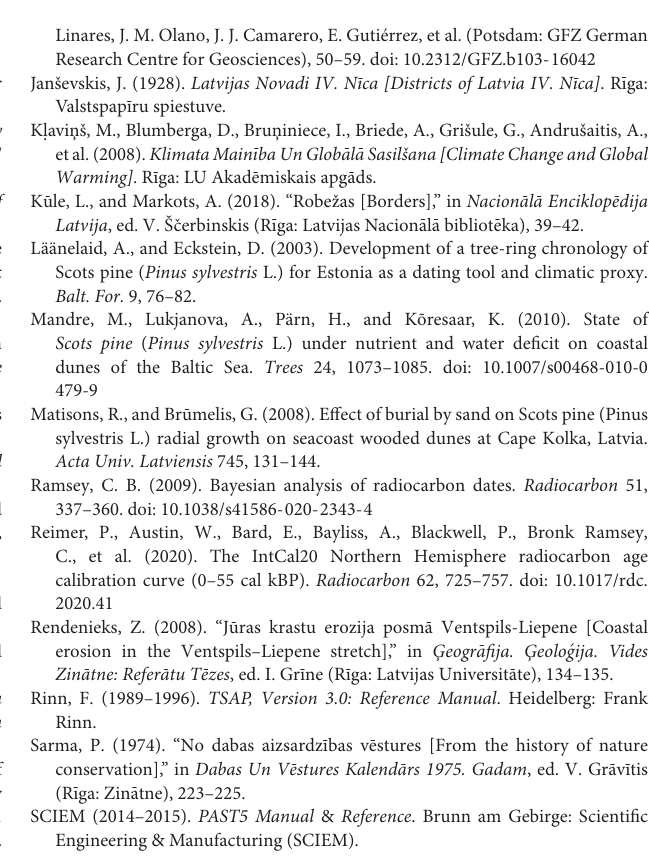
Supplementary Table 1 | Previously and newly obtained 14 C datings utilized in the study. Supplementary Table 2 | T -values indicating the degree of similarity between the tree-ring series of pines selected along the transects, extracted from the overall matrix. The empty cells indicate cases where the similarity of the pairs of TRW series in synchronous position shows a t -value which is not among the five highest t -values for the similarity between the two TRW series (i.e., the five highest t -values are